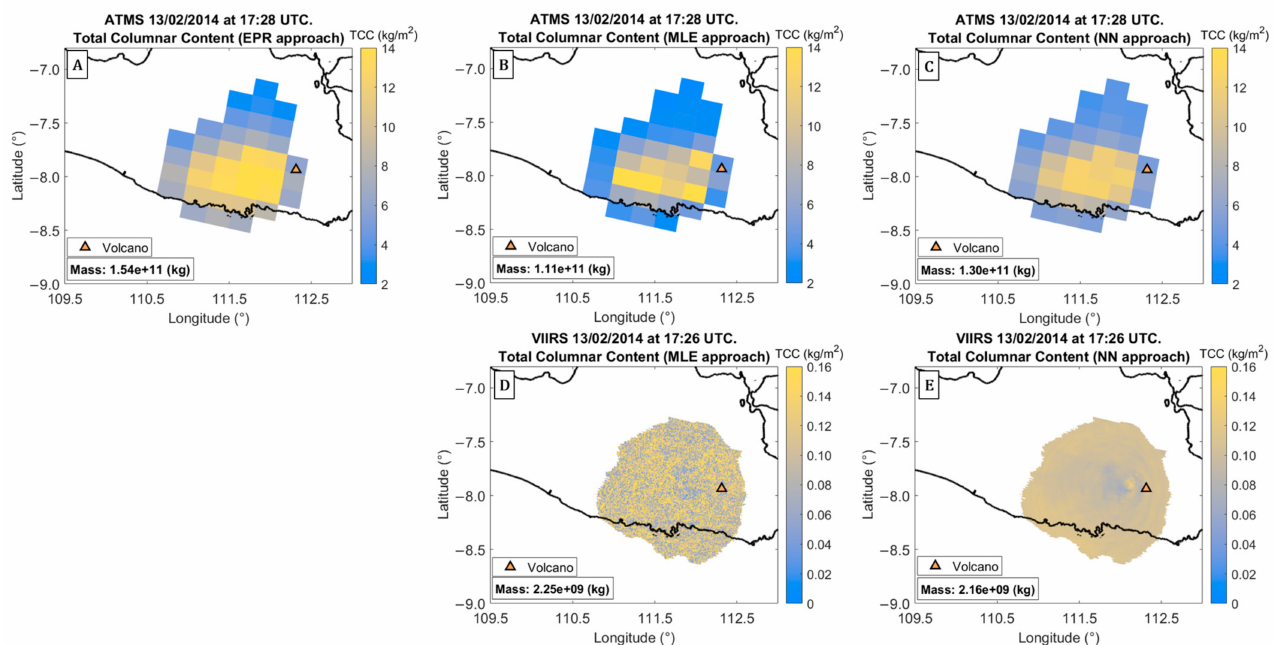
Figure 10. The Kelud eruption on 13th February 2014. (First row) The retrieval for the MW-MMW observations, where ( A ) the TCC map and mass estimates by the EPR; ( B ) the TCC map and mass estimates by the MLE; ( C ) the TCC map and the mass estimates by the NN. (Second row) The retrieval for TIR observations, where ( D ) the TCC map and the mass estimates by the MLE; ( E ) the TCC map and the mass estimates by the